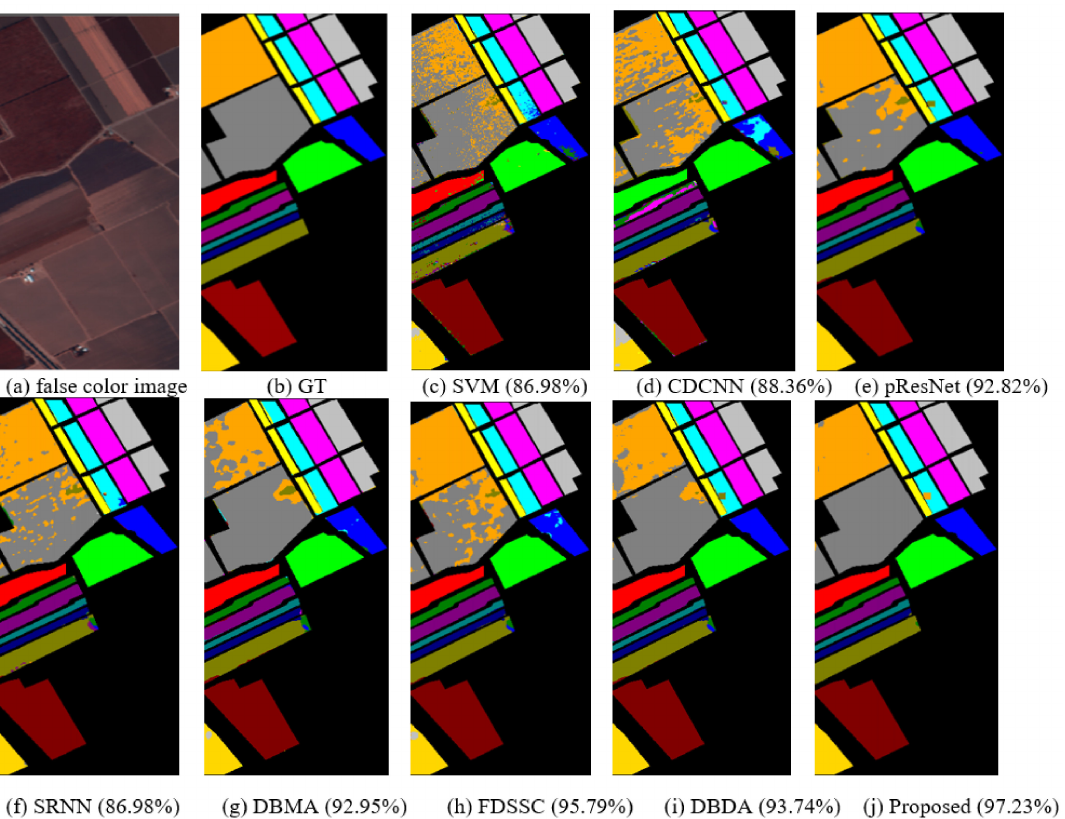
Figure 9. Classification maps of SV data set using 0.5% training samples: ( a ) false color image, ( b ) ground truth map (GT) and ( c – j ) the classification map and overall accuracy of different